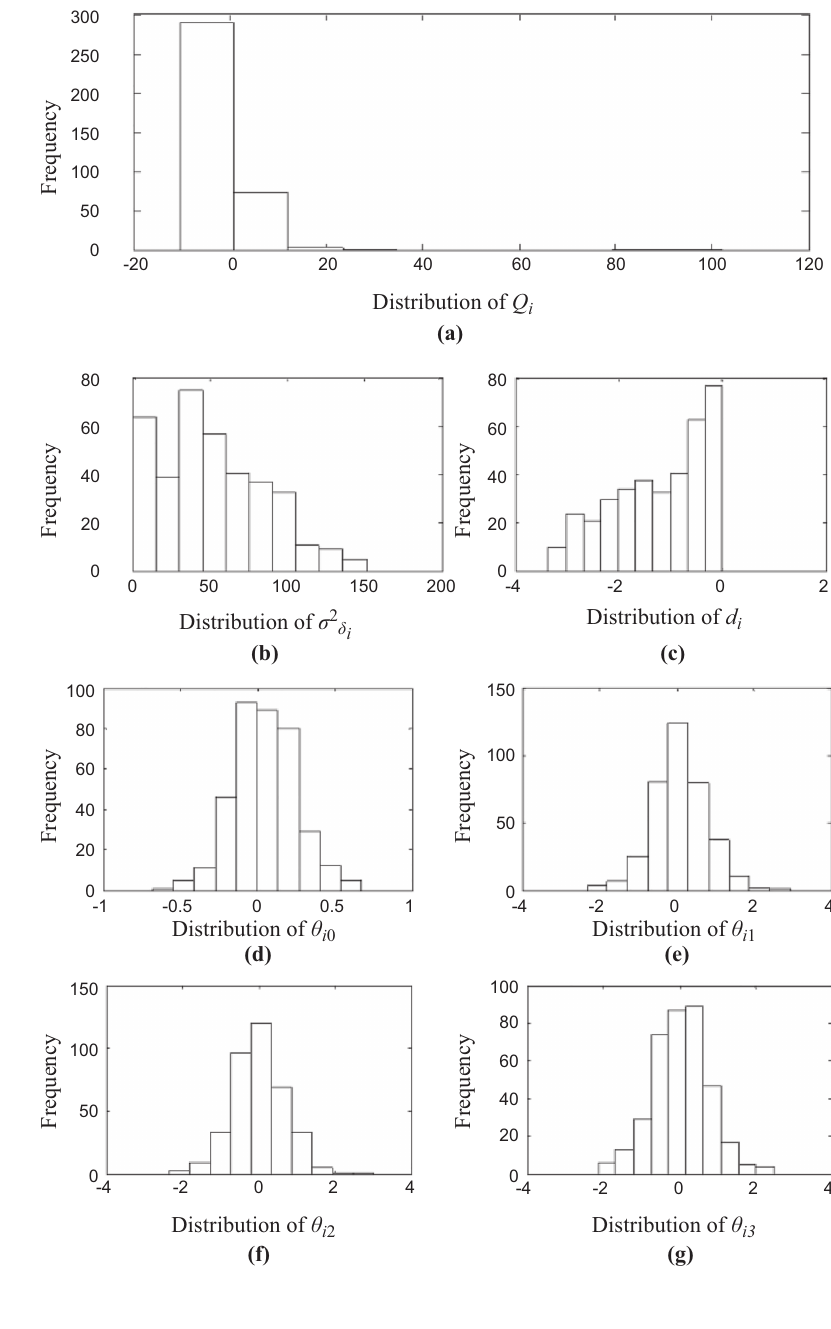
Figure 2. Distributions of the individual-level